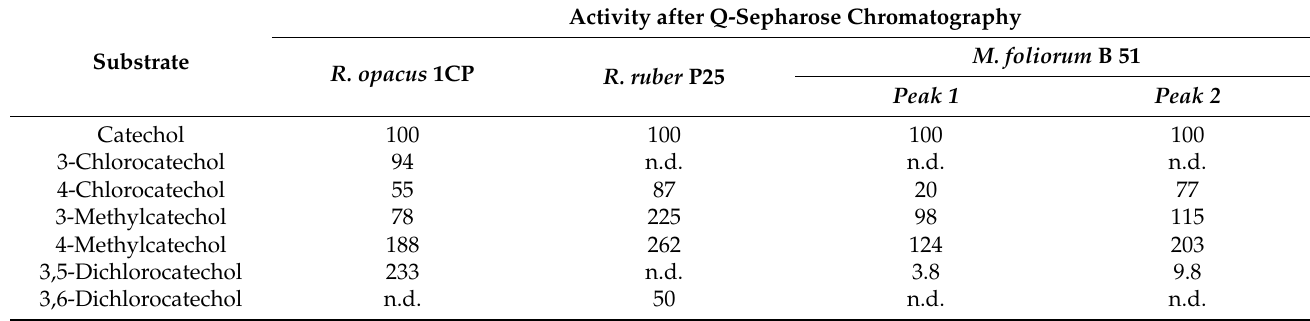
Table 4. Related activity (%) of CCat 1,2-DO of 3CBA grown